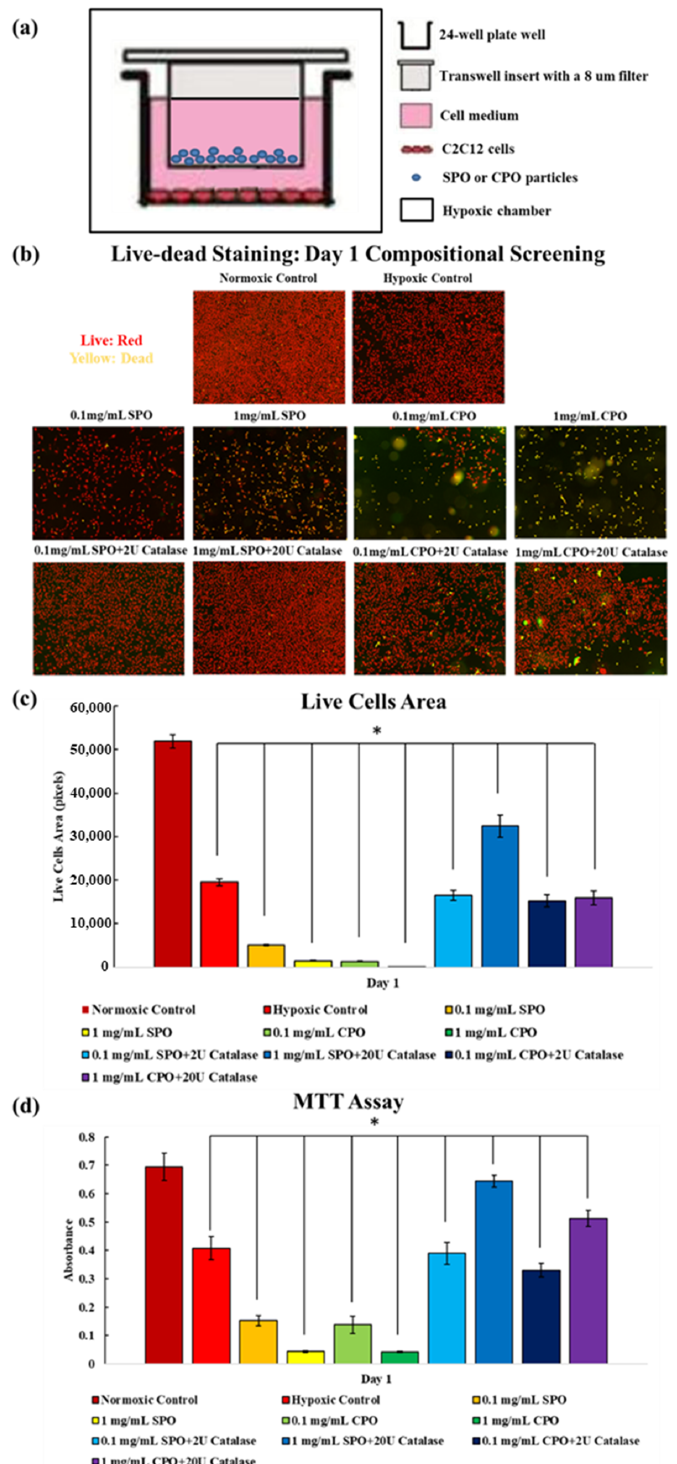
Figure 2. ( a ) Schematic of the novel in vitro cell-culture-insert setup. ( b ) Live–dead staining of C2C12 cells cultured for 24 h in different concentrations of SPO and CPO, as well as different concentrations of SPO/catalase and CPO/catalase. All samples were cultured under hypoxic conditions except the normoxic control. Red indicates living cells and yellow indicates dead cells. ( c ) The images were analyzed to quantify the area occupied by cells dyed red, indicating the living cell population. This measurement is compared across each treatment condition. ( d ) MTT assay results from different conditions after culturing for one